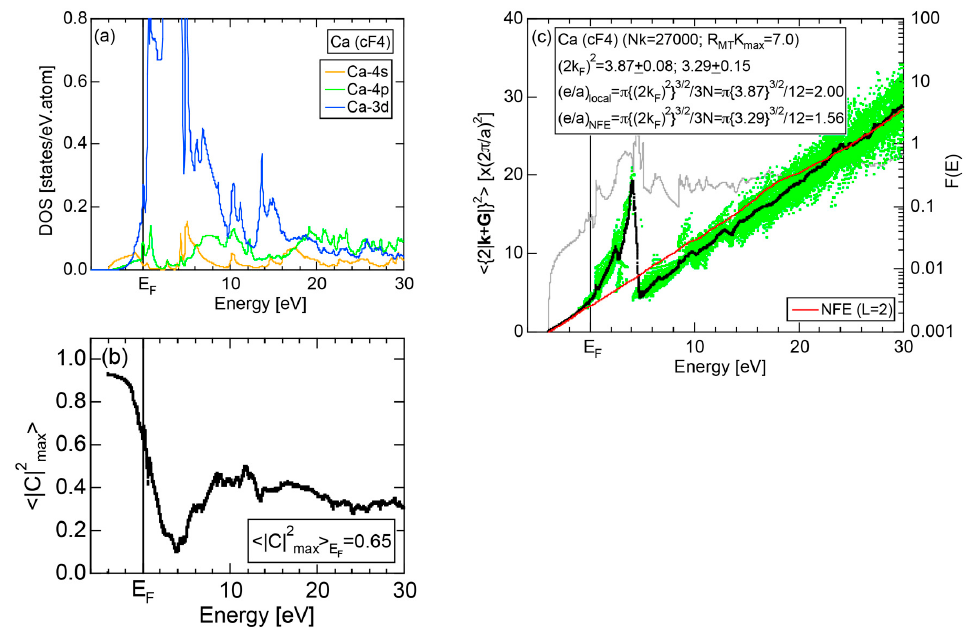
max2 (cid:68) (cid:69) and ( c ) Hume-Rothery plot for Ca (cF4). See captions | C | 2 and ( c ) Hume-Rothery plot for Ca (cF4) [11,15,16,37]. E max E